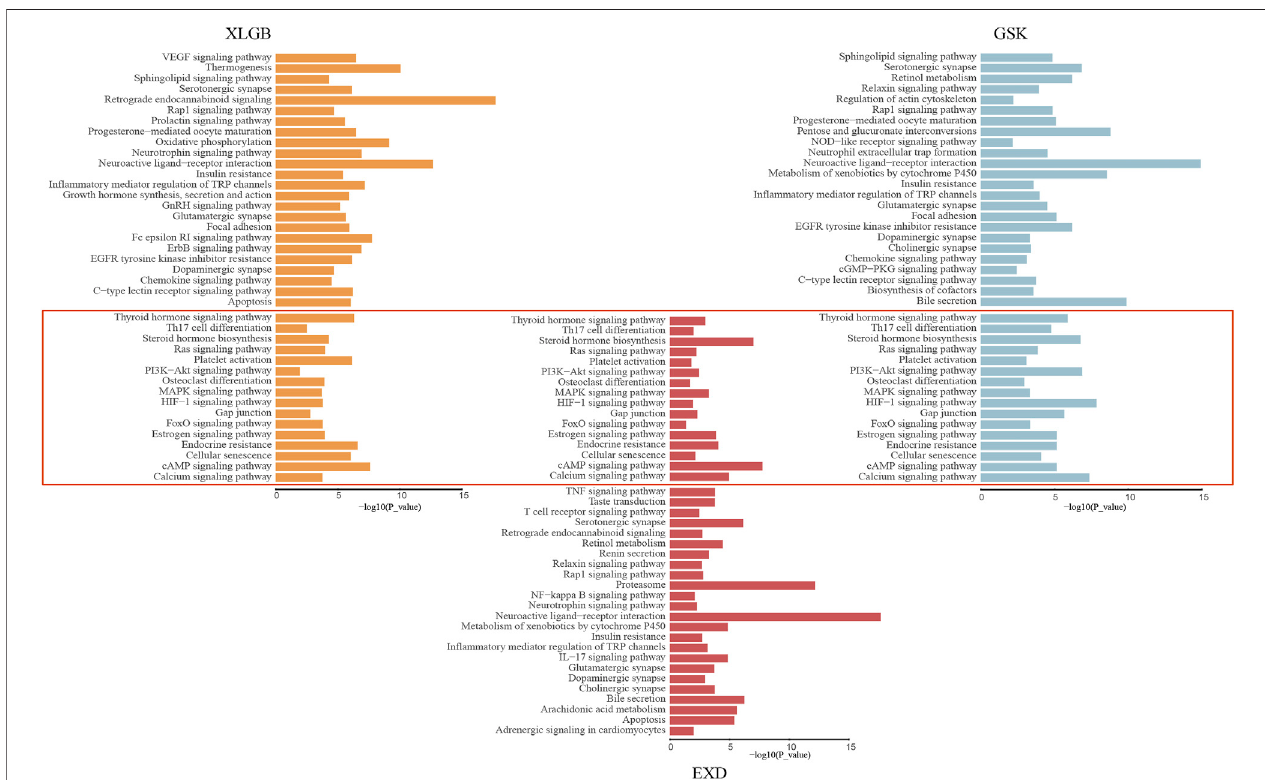
FIGURE 9 | The speci fi c and the common enrichment pathway of FRMs in GSK, XLGB, and EXD.